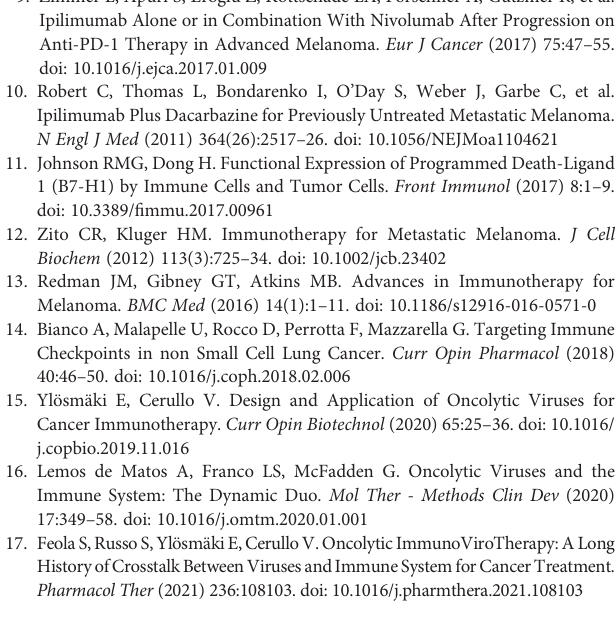
Supplementary Figure 1 | Figure Legend: Puri fi cation and characterization of anti-PD-L1scFv. (A) SDS-PAGE ofperiplasmicextract ofbacteriacellstransformed with the cDNA encoding the anti-PD-L1 scFv before (lane 3) and after puri fi cation (lanes 4-6) by af fi nity chromatography. An unrelated scFv (lane 2) was used as a control. (B) Western blotting analysis of the eluted fraction (as in lane 5 of panel A ). (C) ELISA assays of the puri fi ed scFv on recombinant PD-L1/Fc at increasing concentrations (nM). (D) A competitive ELISA assay performed by PD-L1 coating on the plate, followed by saturation with the unlabeled scFv and incubation with biotinylated PD-1 or B7, demonstrate the ability of anti-PD-L1-scFv to interfere in the interaction between PD-1and B7. Errorbars were calculated onthe basis ofthe results obtained in triplicates by at least two independent